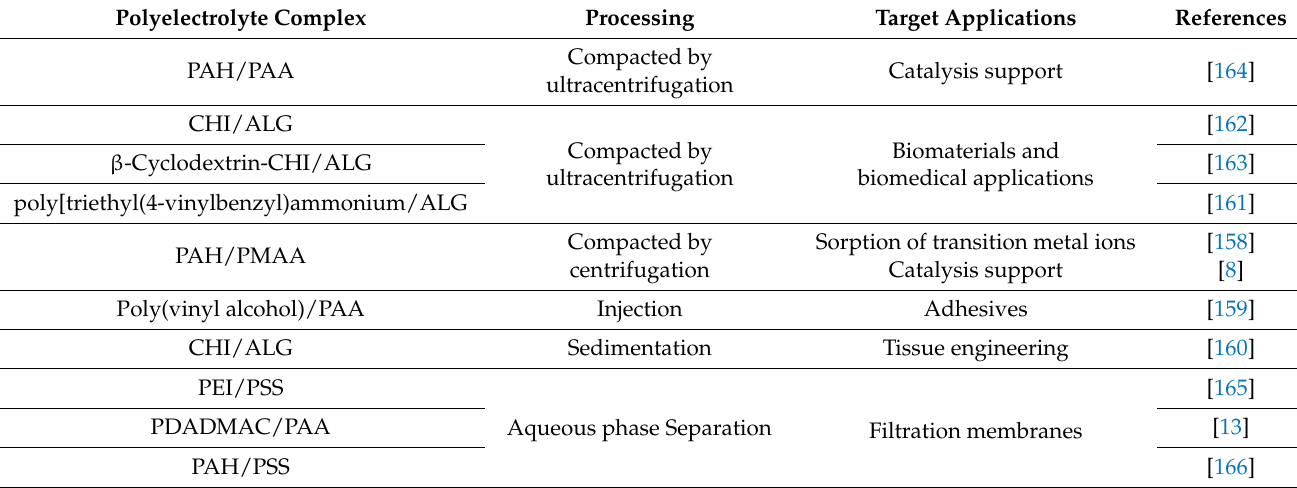
Table 6. Recently reported weak polyelectrolytes complexes processed into gels and emerging